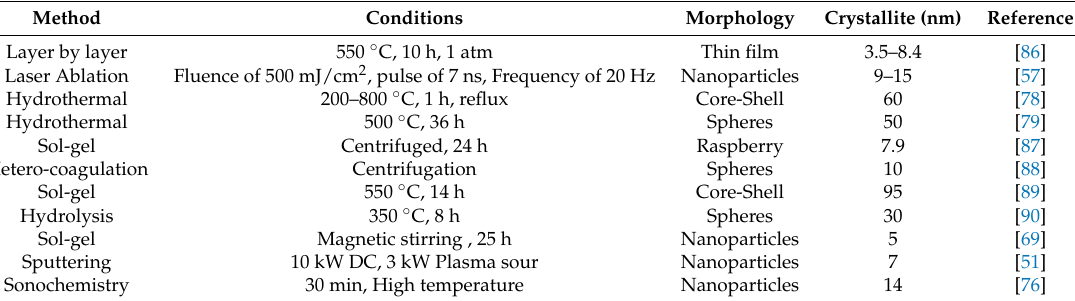
Figure 3. Morphology of the TiO 2 –SiO 2 composite. Table 1. Methods and synthesis of the Si 2 -TiO 2